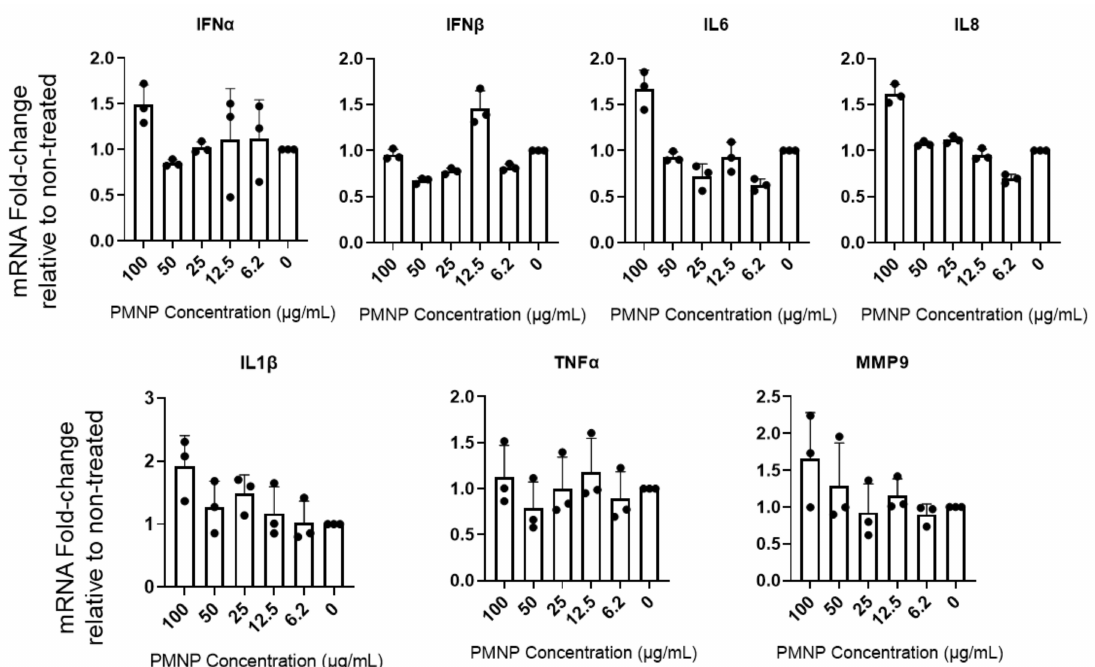
Figure 6. Vero-PMNPs stimulate interferon response. HCE cells were incubated with mock PBS (negative control) or different concentrations of PMNPs. At 24 h post incubation, the cDNA was analyzed for the presence of the desired transcripts using a qRT-PCR